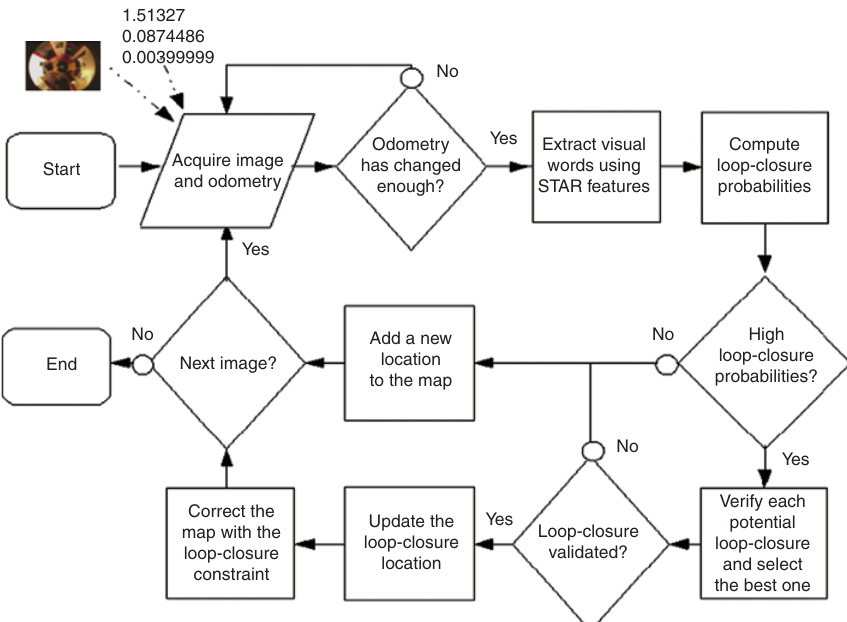
Figure 3. Processing Diagram of the Topometric Map-Building